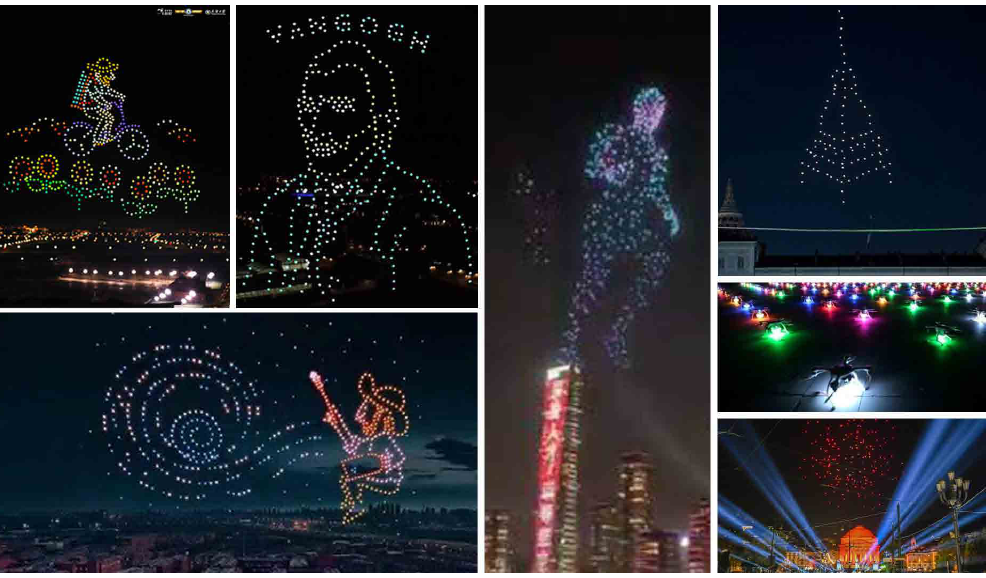
Fig. 14 From left to